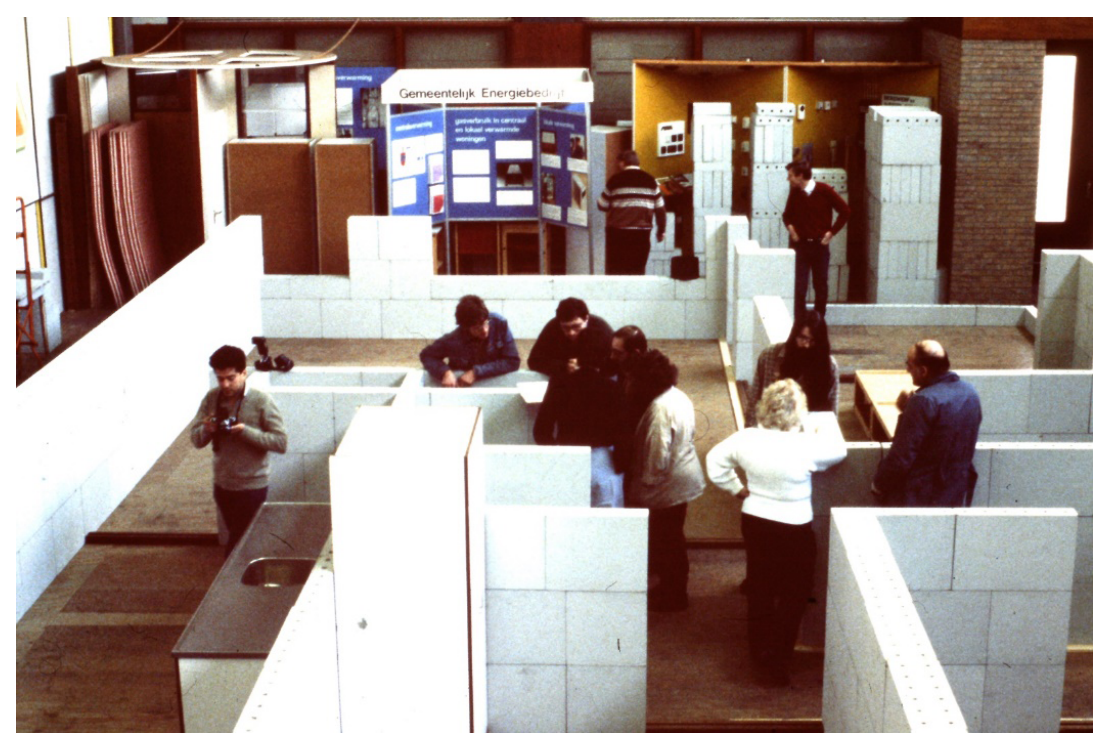
Figure 7. Álvaro Siza speaking with residents at the ROL in 1985. Photograph courtesy of Fred van der Burg. out of the dwellings accommodated most of the feed- back of the